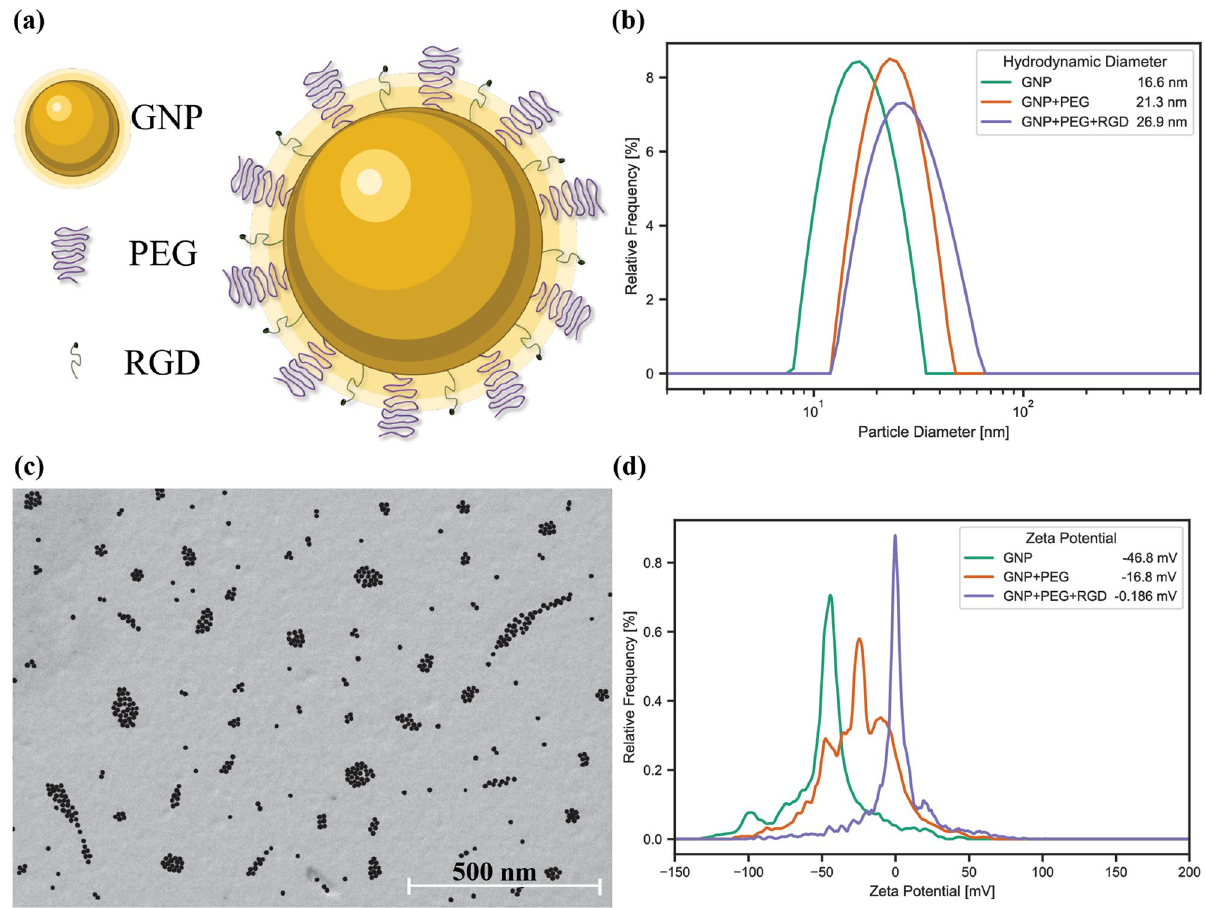
Figure 2. Gold nanoparticle characterization. ( a ) Gold nanoparticles are decorated with polyethylene glycol (PEG) for improved stability and a peptide containing integrin binding domain RGD, to improve uptake into tumours. ( b ) The hydrodynamic diameter of the gold nanoparticles was measured using dynamic light scattering, following functionalization with PEG and RGD. ( c ) Scanning electron microscopy of the gold nanoparticles. Scale bar is 500 nm. ( d ) ζ -potential of the gold nanoparticles before and after functionalization with PEG and